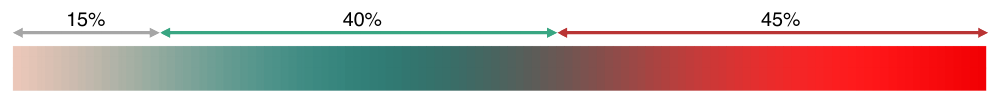
Figure 10. Division of the color scale